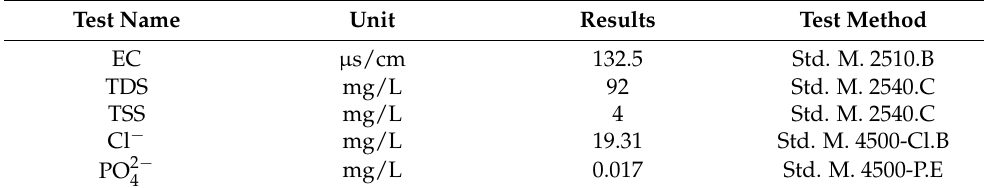
Table 3. Physical and chemical properties of water